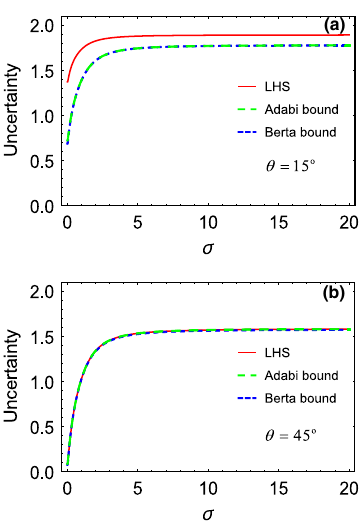
Fig. 1 The LHS, Adabi bound, and Berta bound with respect to the expansionrapidity σ whenconsideringtwocomplementaryobservables (σ ,σ ) . ε = 19999 . 5, (cid:14) = 2, μ x y